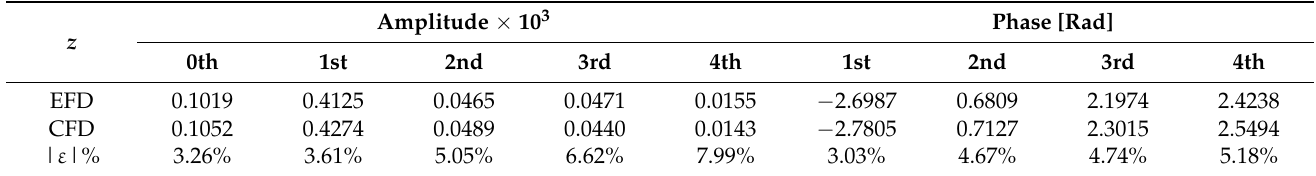
Table 21. Harmonic amplitudes and phases of heave for the FRxz ϕθ quartering waves scenario.